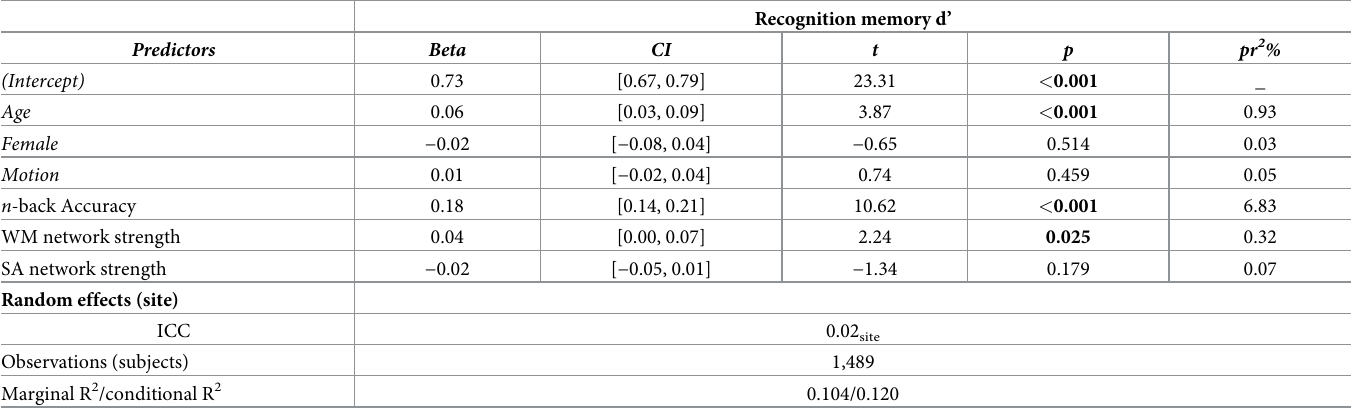
Table 3. WM network strength during in-scanner n -back task performance is related to subsequent recognition memory for n -back task stimuli after adjusting for nuisance variables and even n -back performance